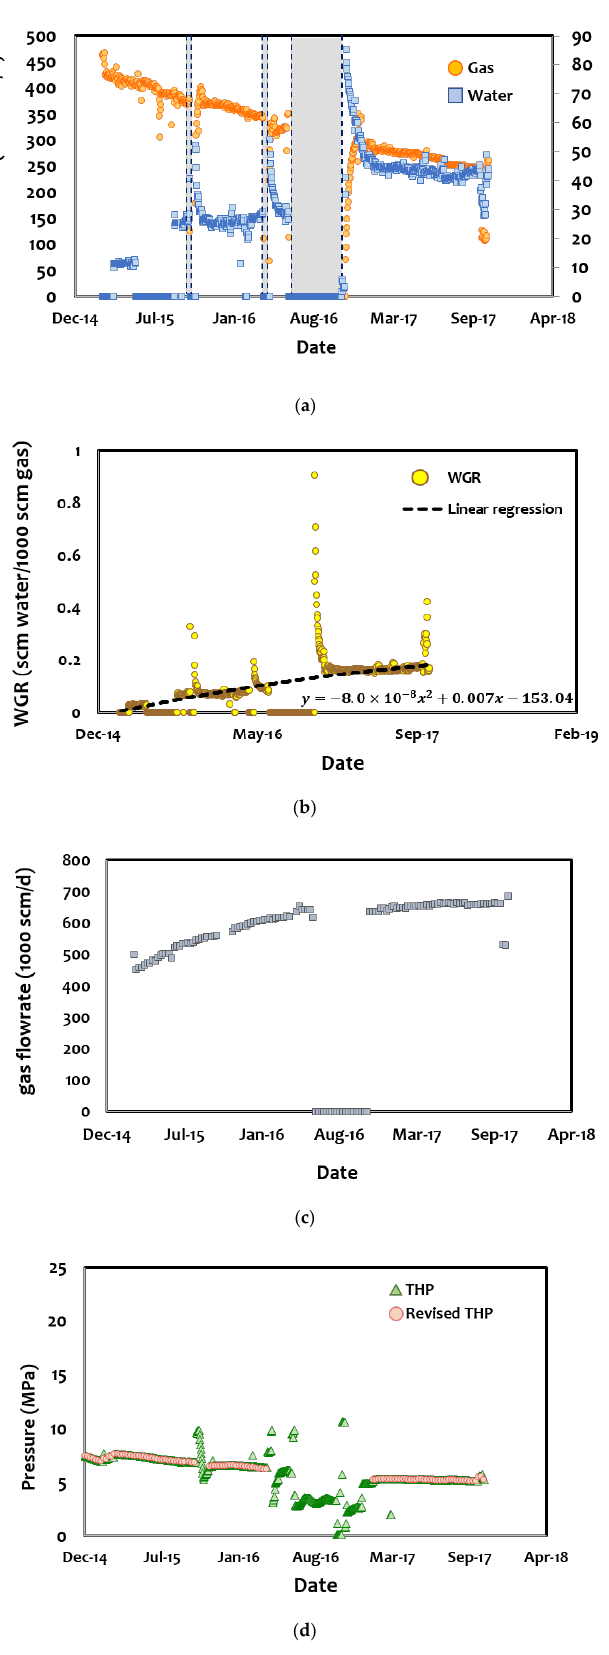
Figure 9. Data preprocessing during the water production period: ( a ) Water and gas rate profiles, ( b ) water–gas ratio profile, ( c ) equivalent gas rate, and ( d ) THP preprocessing.